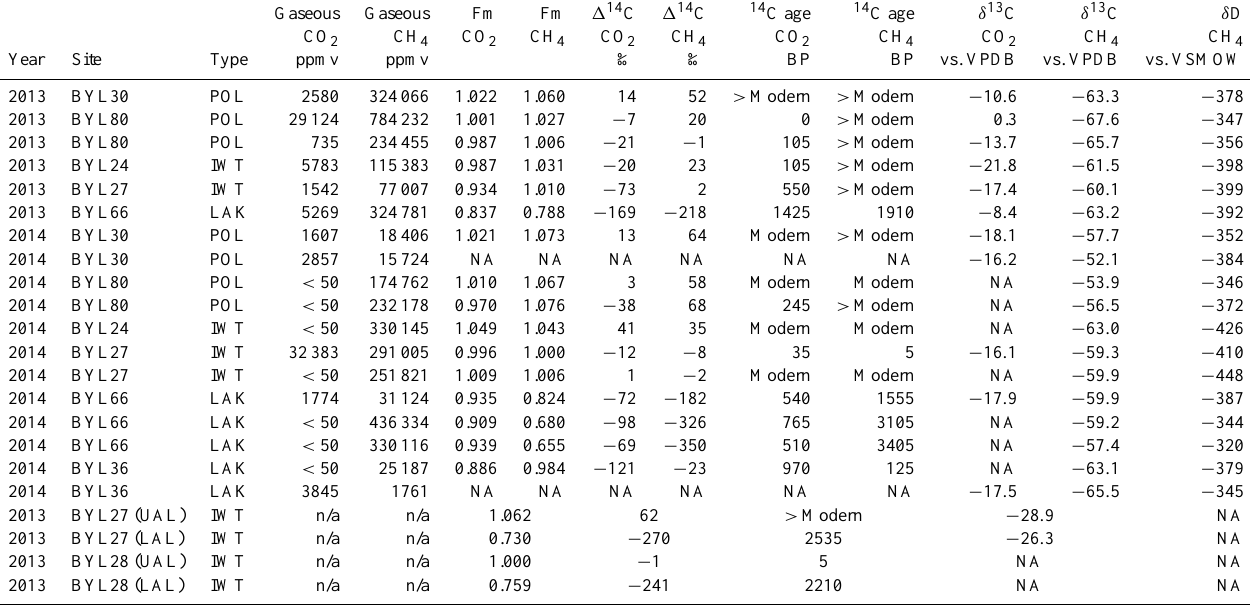
Table 2. Greenhouse gas radiocarbon and stable isotope results for the six priority ponds and lakes sampled during 2 consecutive years (2013 and 2014). Active layer samples collected in 2013 near two trough ponds are also included. POL = polygonal pond; IWT = ice wedge trough pond; LAK = lake; UAL = upper active layer (0–5cm); LAL = lower active layer (50–60cm); Fm = fraction modern.